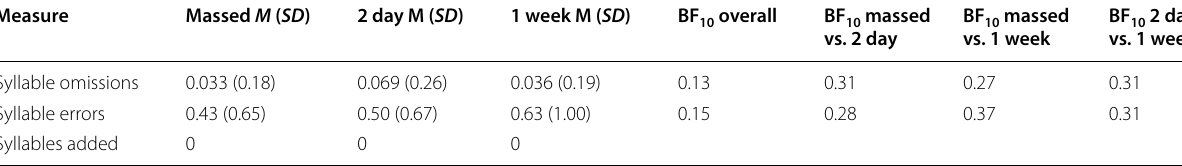
Table 7 Learning outcome: syllables (test 1.3), for massed, 2-day, and 1-week ISIs Measure